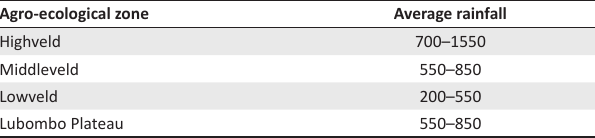
TABLE 2: Rainfall in the agro-ecological zones of Eswatini. Agro-ecological